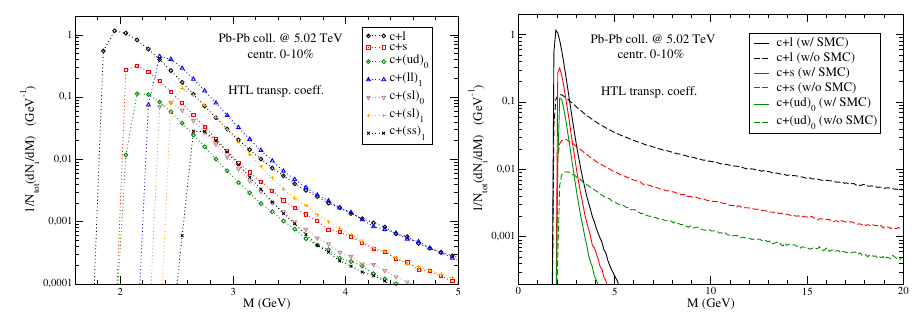
Figure 1. Left panel: the invariant-mass distribution of the Qq and Q ( qq ) clusters at the hadronization hypersurface in the di ff erent isospin, strangeness and spin channels. Right panel: cluster invariant-mass distributions in case recombination occurs locally (continuous curves, default implementation), with strong correlation between the parton momenta and position, or non-locally (dashed curves), with no space-momentum correlation. All results refer to central Pb-Pb collisions at √ s NN = 5 . 02 TeV, with charm quark propagation before hadronization described by HTL transport coe ffi